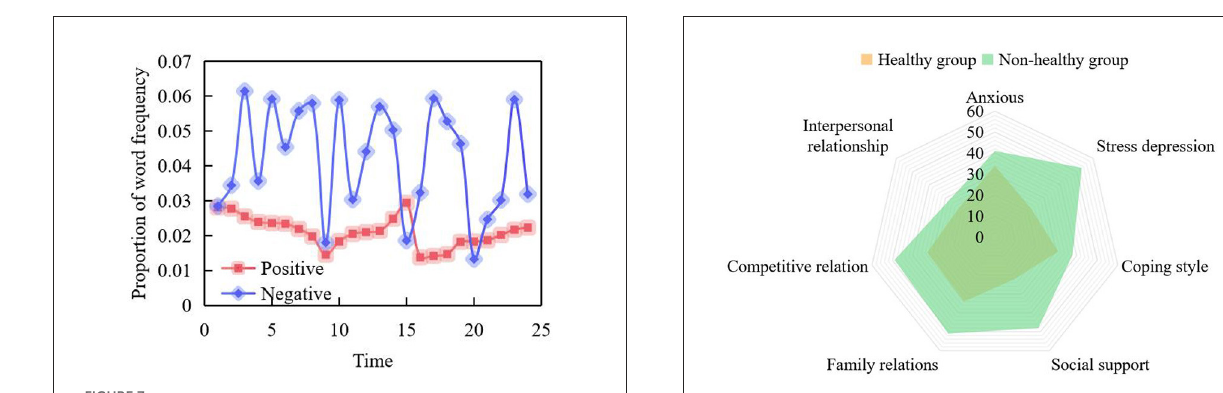
FIGURE7 And that change of positive and negative emotional words with time.